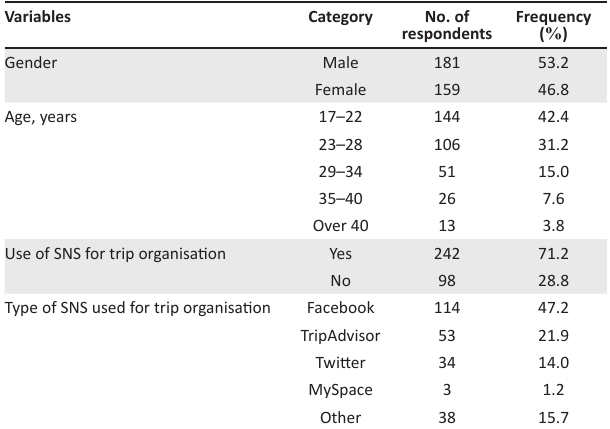
TABLE 1: Respondents’ background